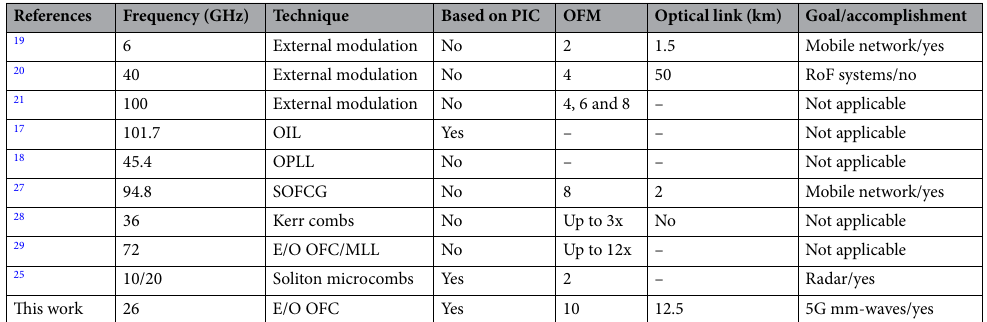
Table 1. Photonics-based frequency generation and